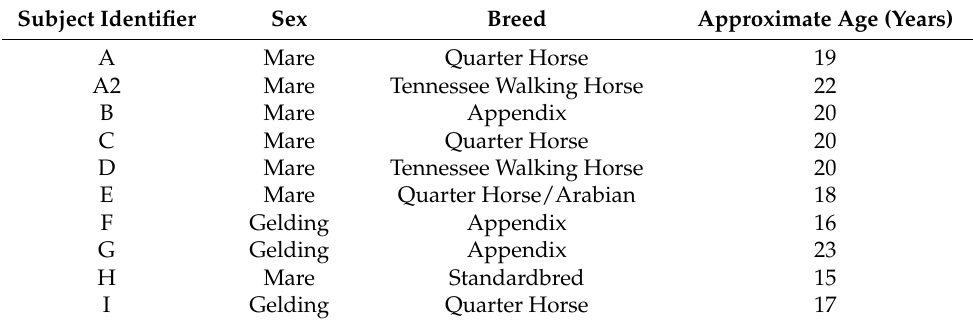
Table 1. Available metadata for equine subjects enrolled in the refeeding